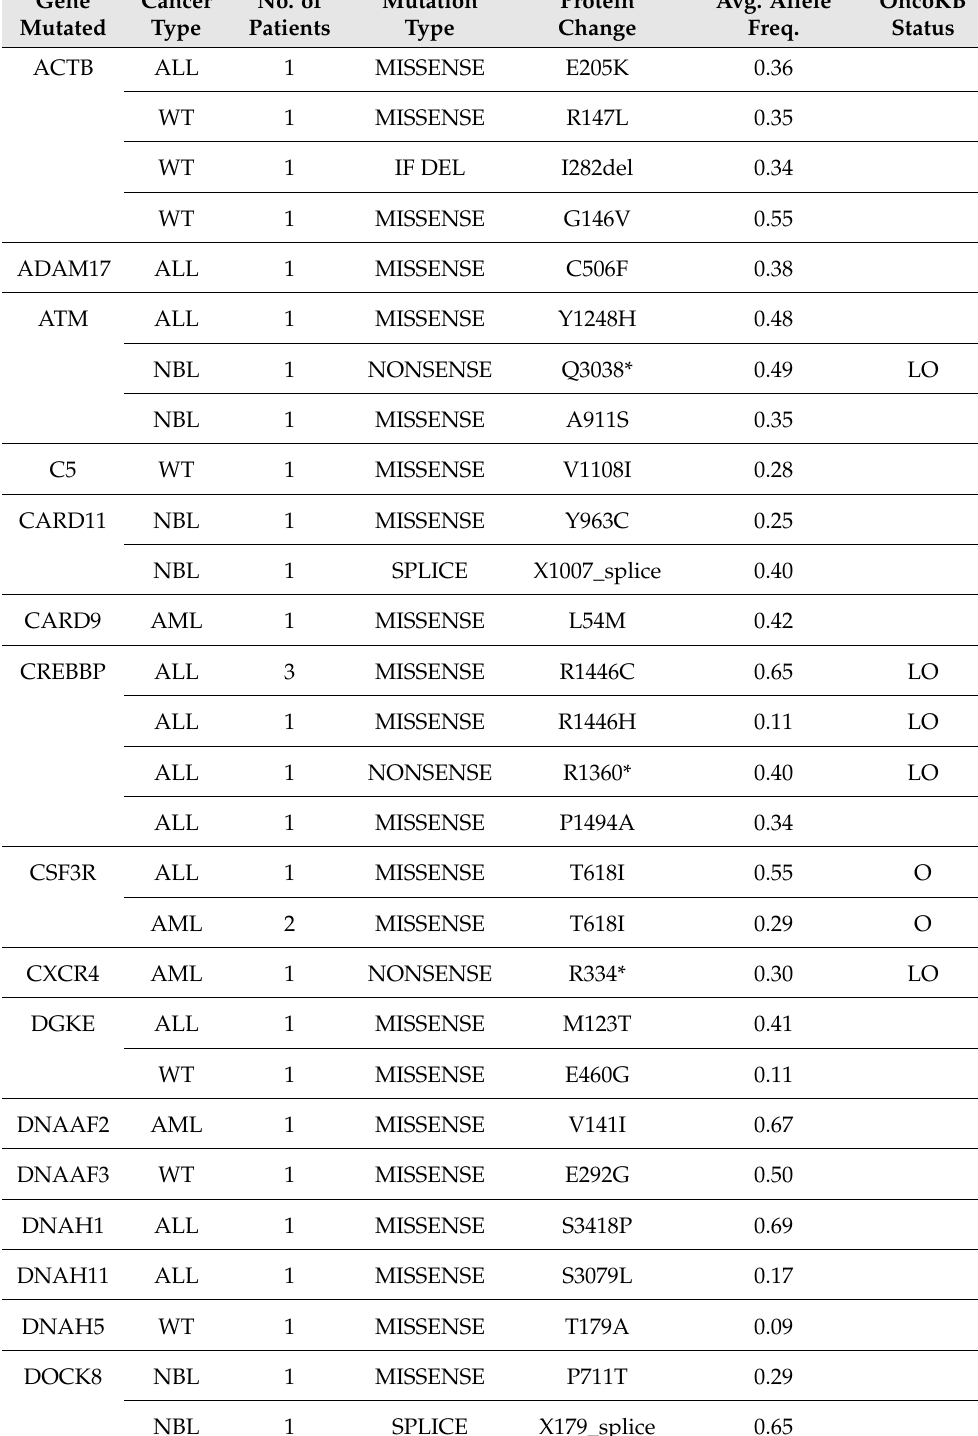
Table 1. Summary of protein changes for 64 PID-related genes identified in patients with the following cancer types: ALL, AML, NBL, RT, and WT. All data were extracted individually for each cancer type on cBioPortal and then